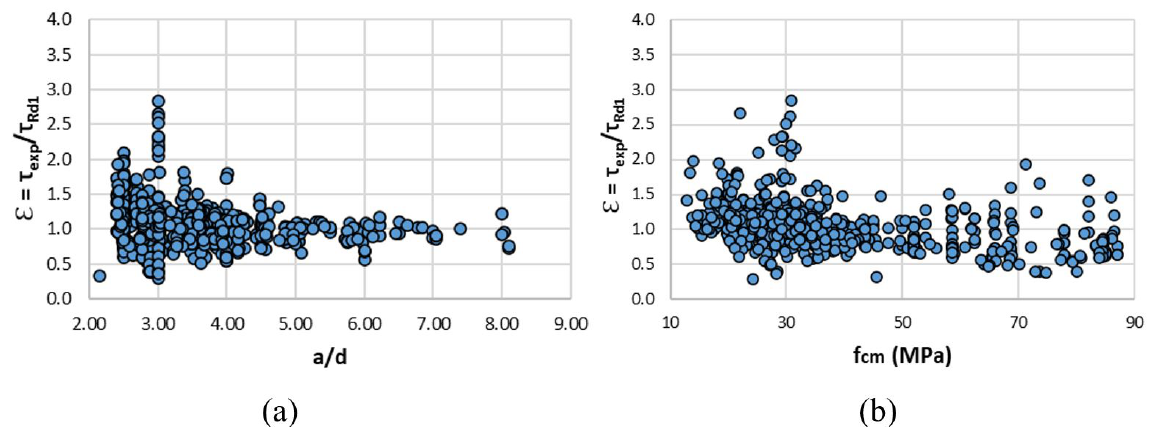
Figure 4. (a) Impact of a/d ratio on model error, (b) Impact of average compressive concrete strength on model